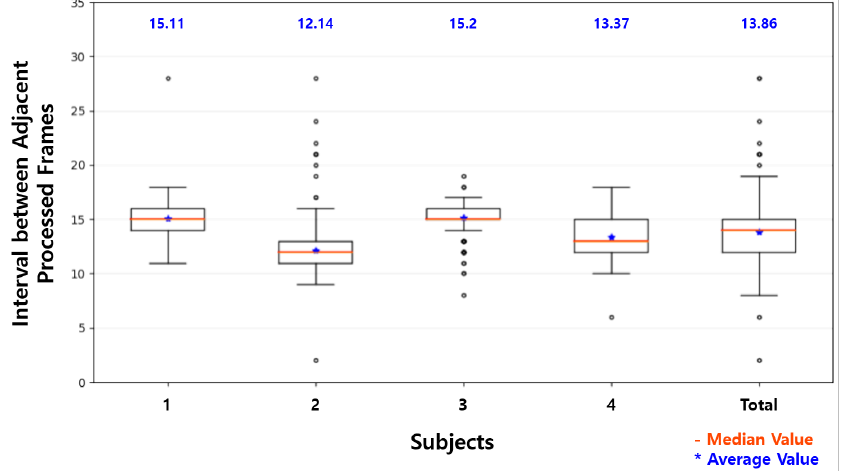
Figure 14. Interval distribution on the Raspberry Pi.